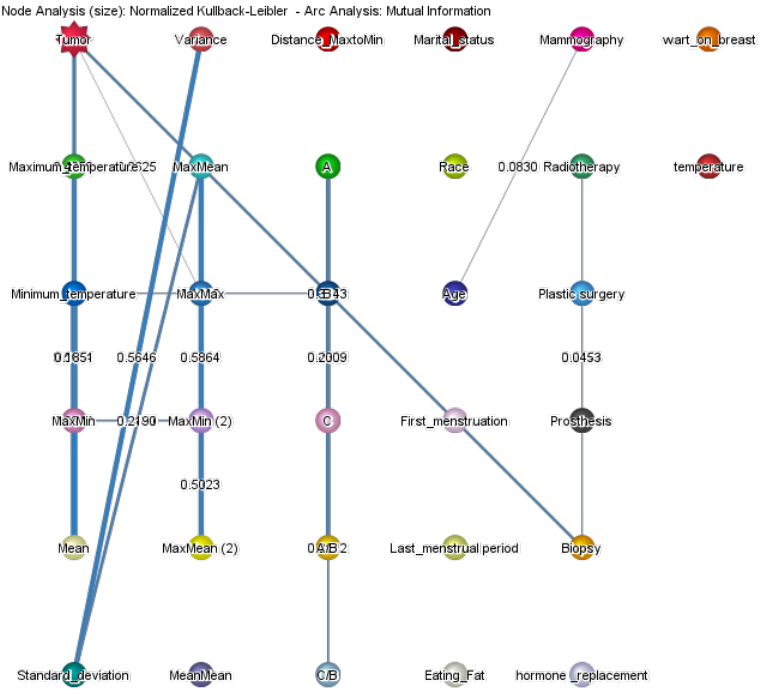
Figure 8. BN structure from unsupervised learning with node strength evaluated with normalized KL divergence and Arc strength evaluated with mutual information.